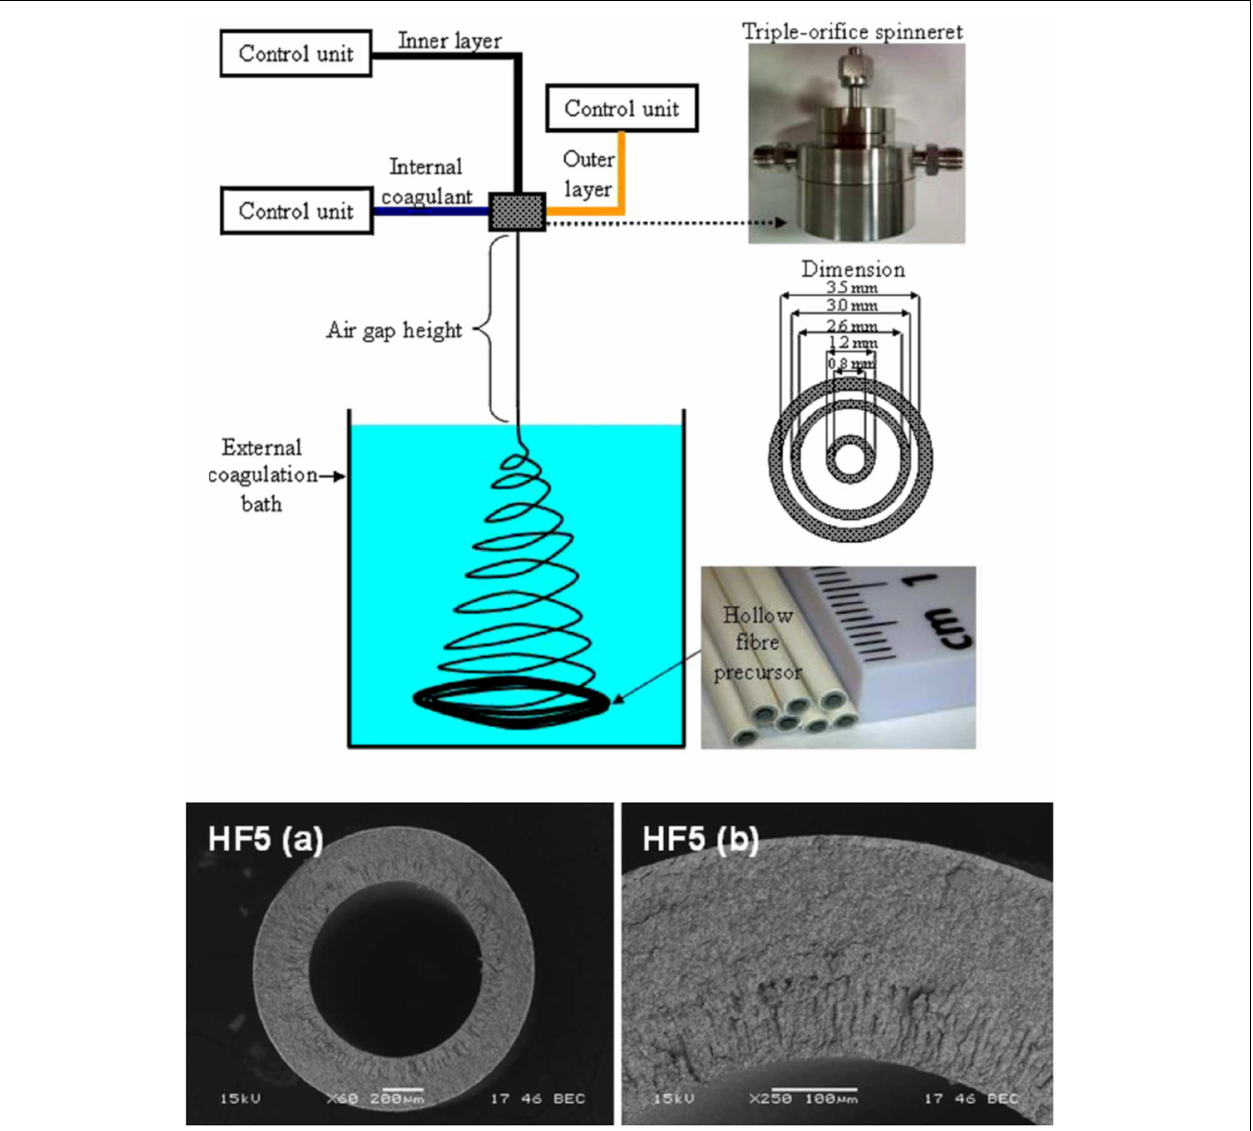
FIGURE 4 | (Above) schematic representation of the phase inversion-based co-extrusion process; (below) SEM images of the (a) overall view and (b) cross-section of the CGO/Ni–CGO dual-layer HF . Reprinted with kind permission from Othman et al.